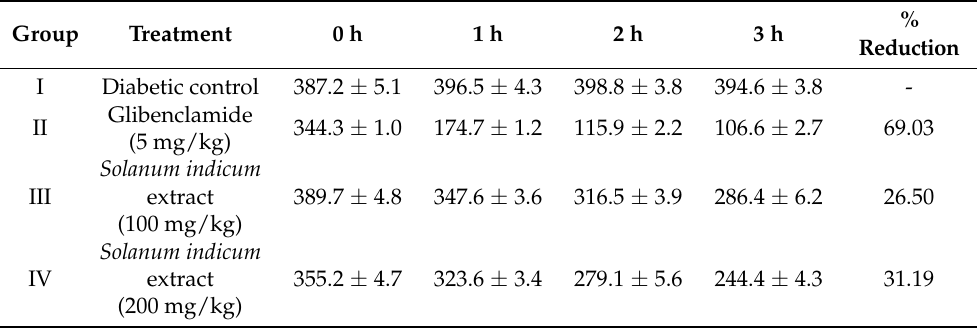
Table 3. Effect of SIE on the fasting blood glucose levels of STZ-induced diabetic rats.